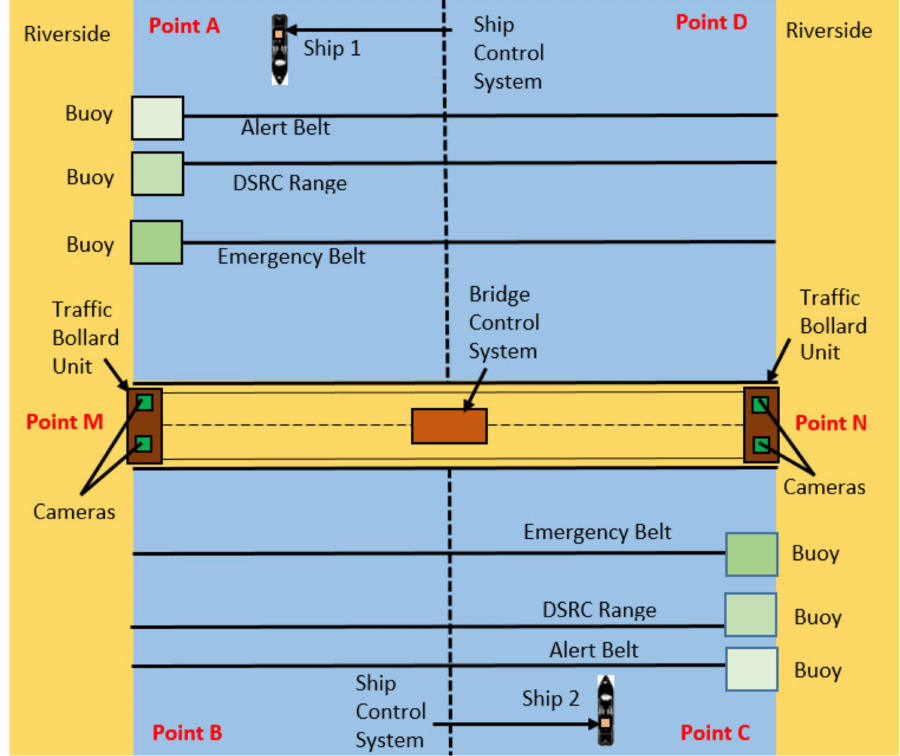
Figure 1. Generalized layout of the system components used in the proposed